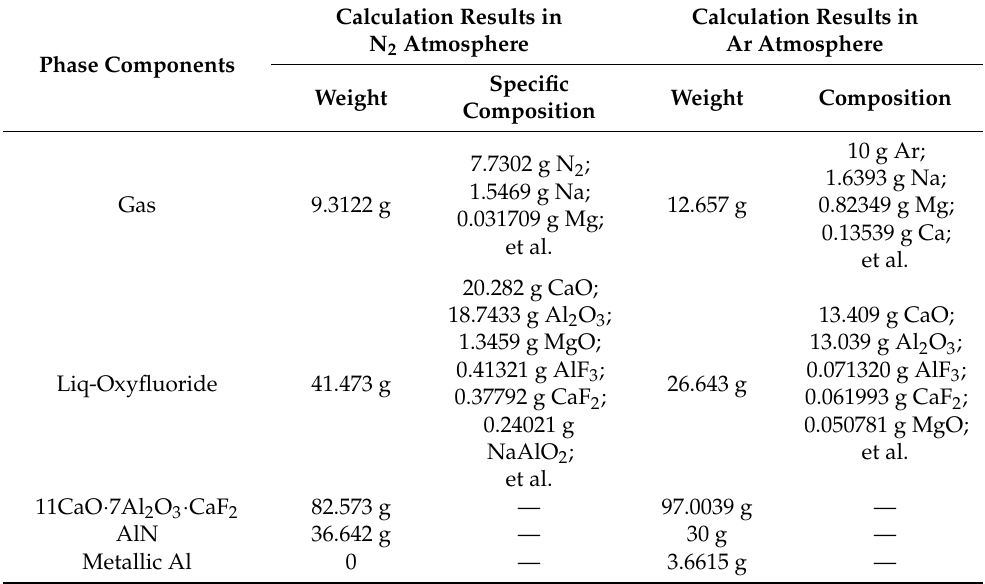
Table 4. Thermodynamic calculation results of the CaO and secondary aluminum dross calcination